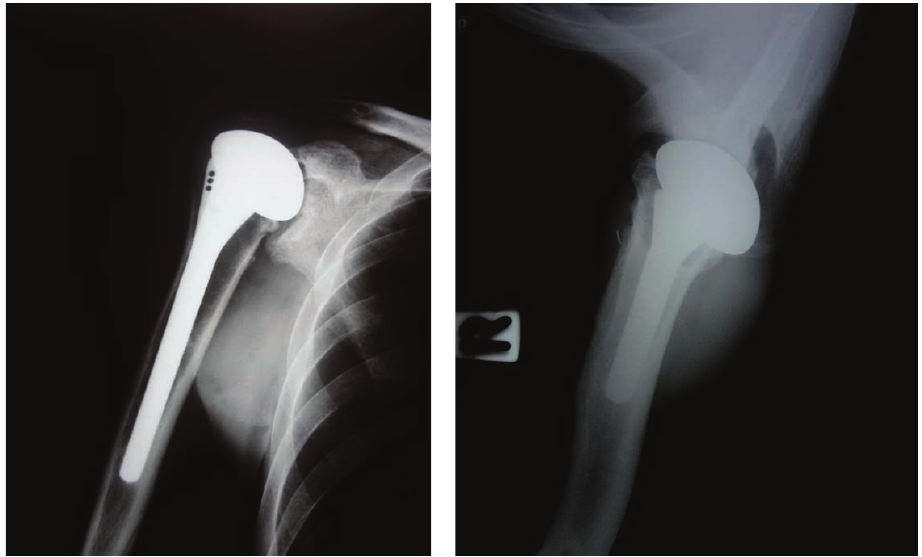
Figure 4: The follow-up radiographs at 60 months postoperatively.